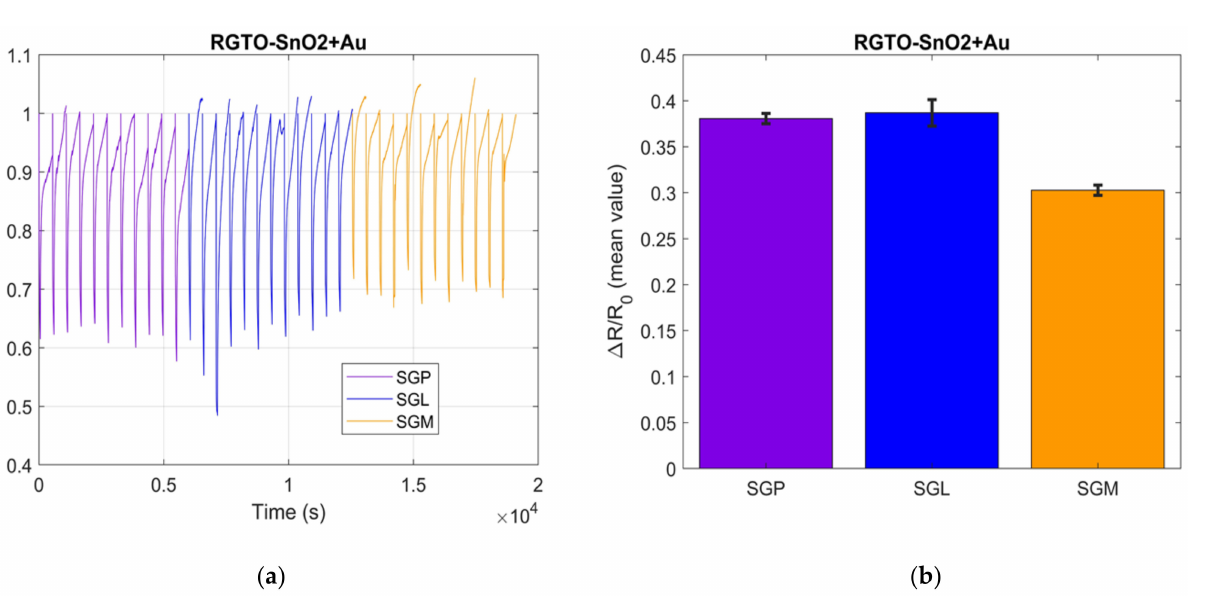
Figure 2. ( a ) Sensor response representation to the green teas RGTO sensor SnO 2 + Au and ( b ) mean values for the ∆ R/R0 with the representation of the SD bar for the different green teas